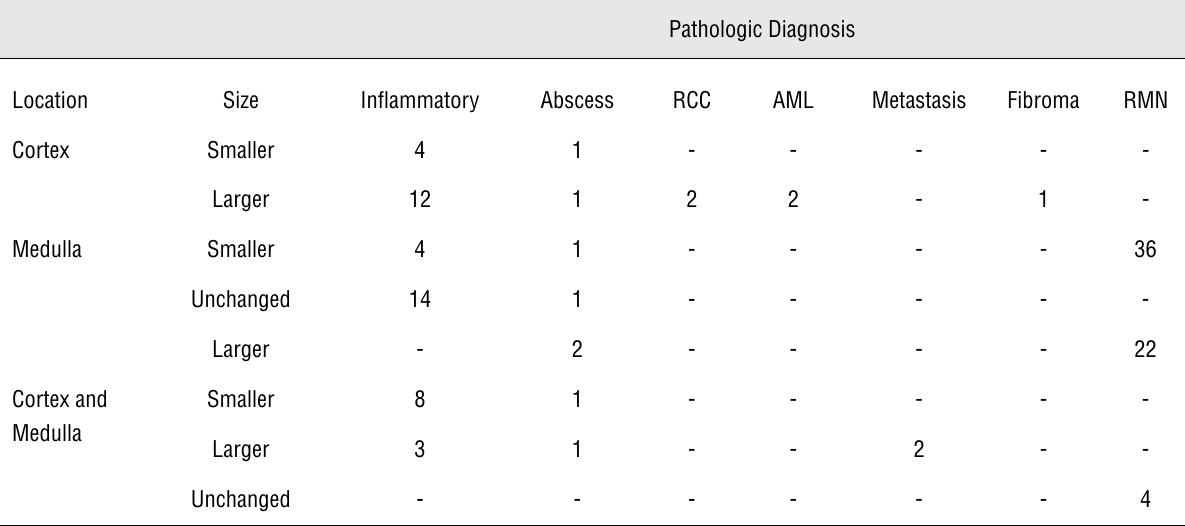
Table 2 - significant and Potentially Treatable Conditions Observed Among 1082 small Renal Masses.